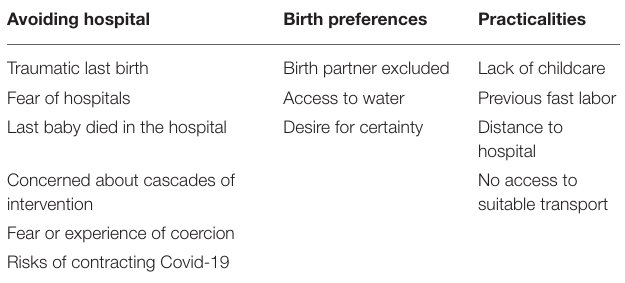
TABLE 3 | Reasons why participants were considering